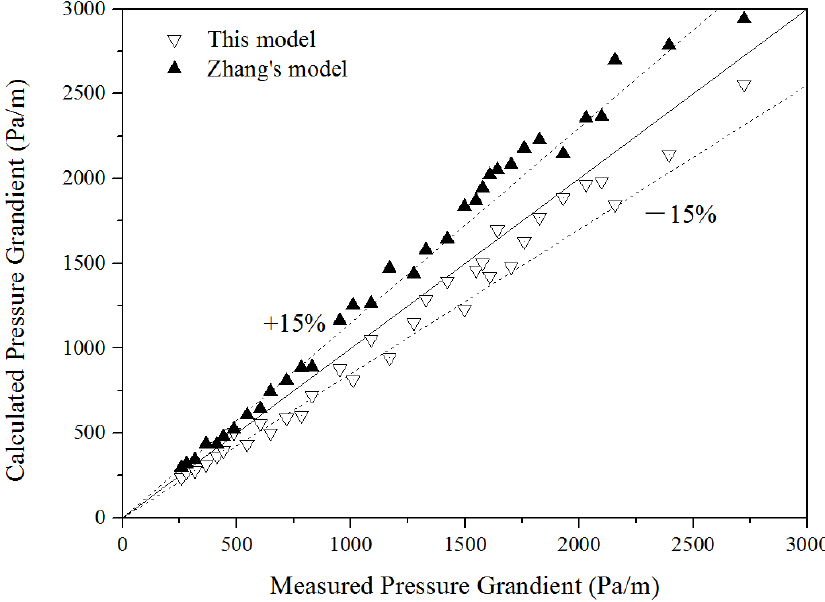
Figure 9. Comparison of the pressure gradient between the two models for the No. 3 experiment. Table 2. Error statistics of the